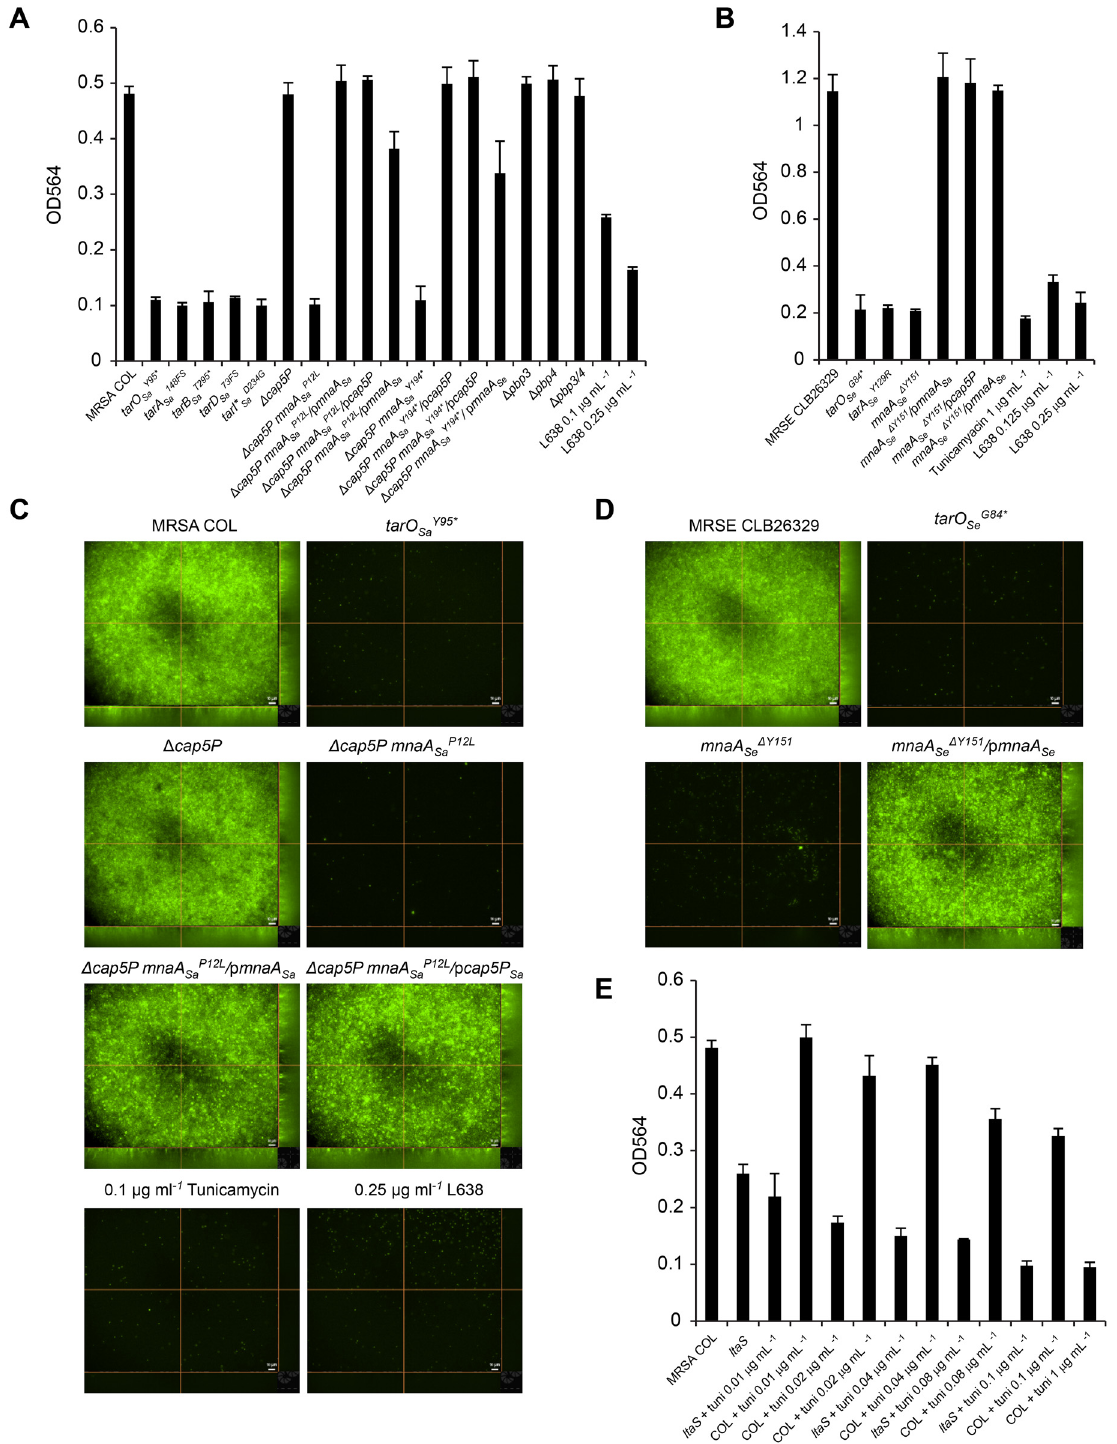
Fig 5. WTA is required for biofilm formation in methicillin resistant Staphylococci . For total biofilm quantification, biofilms were grown in triplicates for 24 hours in 96-well plates with or without indicated sub-MIC concentrations of WTA inhibitors for MRSA COL (A,C,E) and MRSE CLB26329 (B,D) strains. Genetic complementation of described mutants was performed using plasmid-based copies of wild-type cap5P (p cap5P ), mnaA Sa (p mnaA Sa ), and mnaA Se (p mnaA Se ) as indicated. Biofilms were stained with safranin and dissolved in glacial acetic acid before OD 564 was measured. Bars represent mean OD, error bars represent standard deviation. For Epi fluorescence microscopy, biofilms of MRSA (C) and MRSE (D) were grown as above in black clear bottom plates and stained with Bac Light Green fluorescent stain. Z-stacks were obtained at 60x magnification. Scale bar = 10 μ